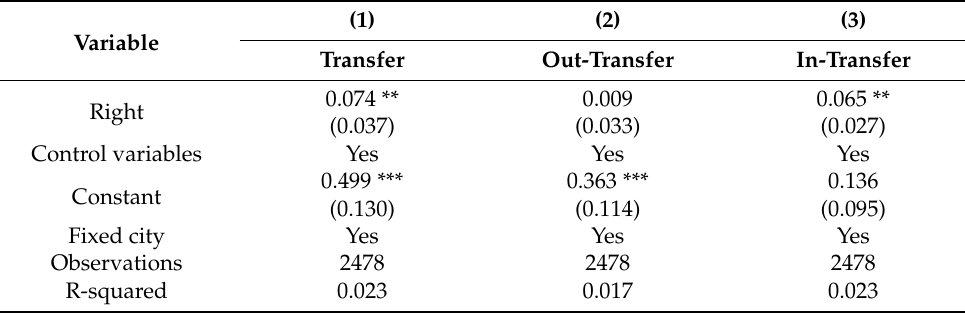
Table 7. OLS regression results of rural land right on intermediary